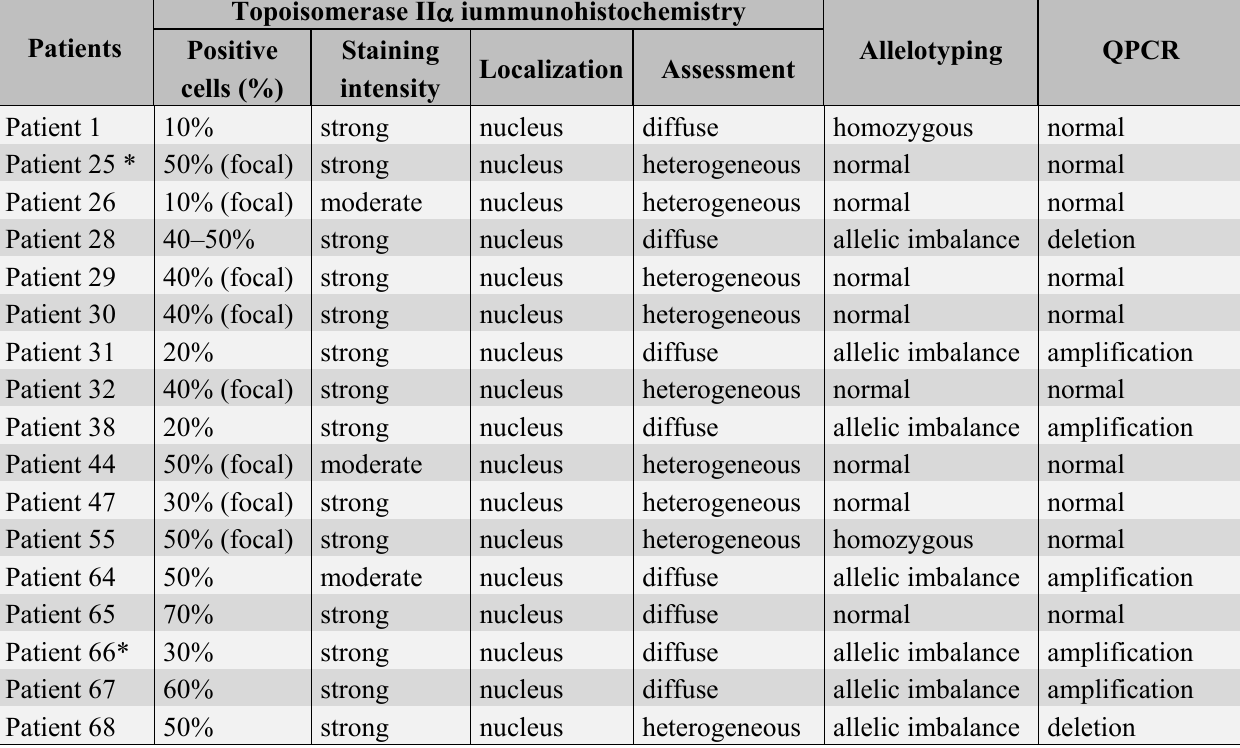
Table 4. The results of topoisomerase IIα immunohistochemistry are showing a frequent link between a diffuse staining and an allelic imbalance at TOP2A locus (six patients). Among these six patients, four were presenting a TOP2A amplification (QCR analyses).